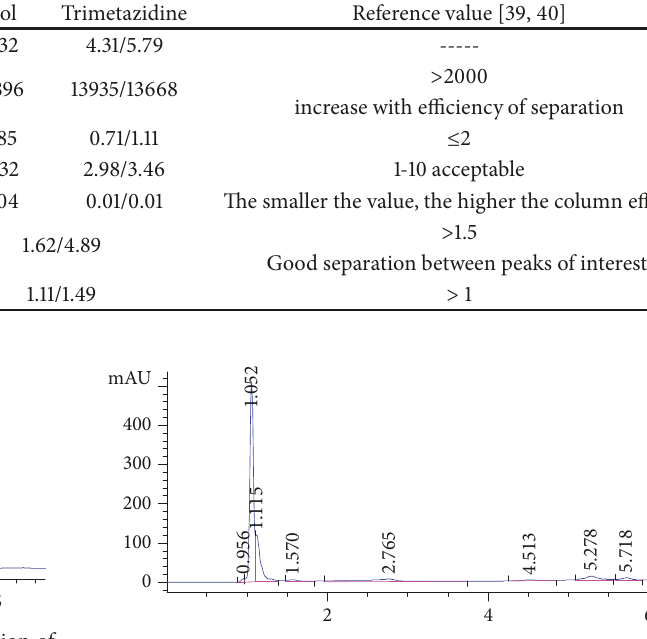
Figure 4: HPLC-PDA chromatogram of blank